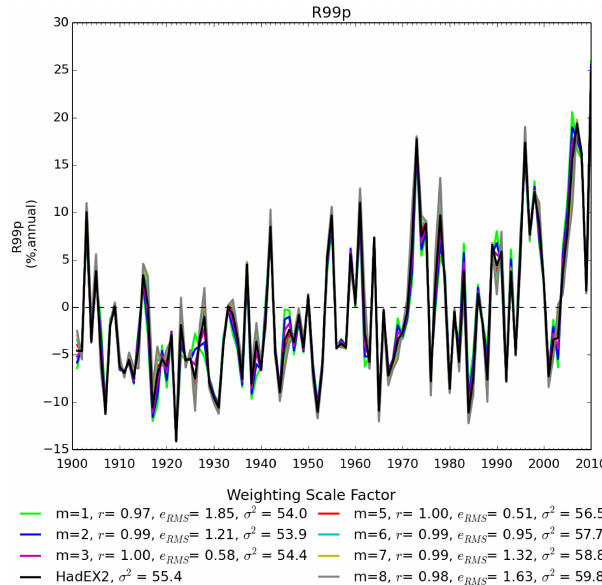
Figure 3. The time series for global average R99p (annual sum of daily precipitation > 99th percentile) showing the different curves for the different weighting values (colours are indicated below the plot). The figure also shows the correlation coefficient ( r ), variance ( σ 2 ) and root-mean-square error ( e RMS ) between each series and HadEX2. All choices have been centred relative to the climatology period 1961–1990, reducing the spread during this